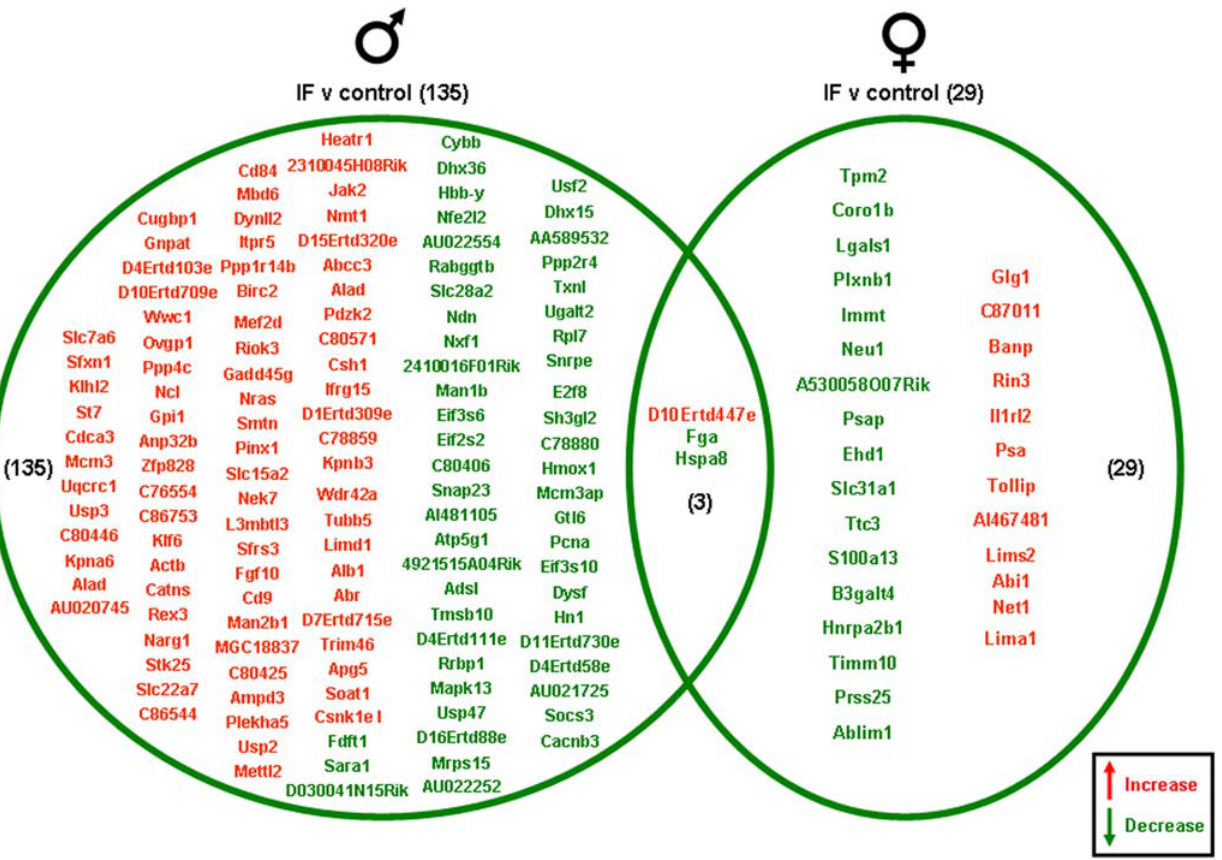
Figure 5. Gene changes in the gonads of male and female rats maintained on an IF diet compared to the gonads of rats maintained on a control ( adlibitum ) diet. Genes that were significantly up-regulated (red) or down-regulated (green) were clustered into a Venn diagram. There were 82 significantly up-regulated and 53 significantly down-regulated genes in the testes collected from IF male rats compared to the genes from testes collected from control ( ad libitum ) male rats. Ovaries collected from IF female rats showed 12 significantly up-regulated (red) and 17 significantly down-regulated (green) genes compared to controls. There were 3 genes that was significantly altered in both the males and females in the IF dietary group compared to the control group. The expressed sequence D10Ertd447e was significantly up-regulated in the gonads of IF males and females, compared to control ( ad libitum ) males and females. The genes Fga and Hspa8 were each down-regulated in IF male and female gonads compared to controls. Names of the significantly altered genes can be found in Table